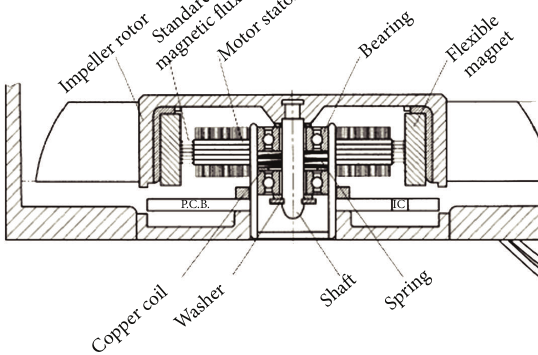
Figure 21: Sleeve bearing.